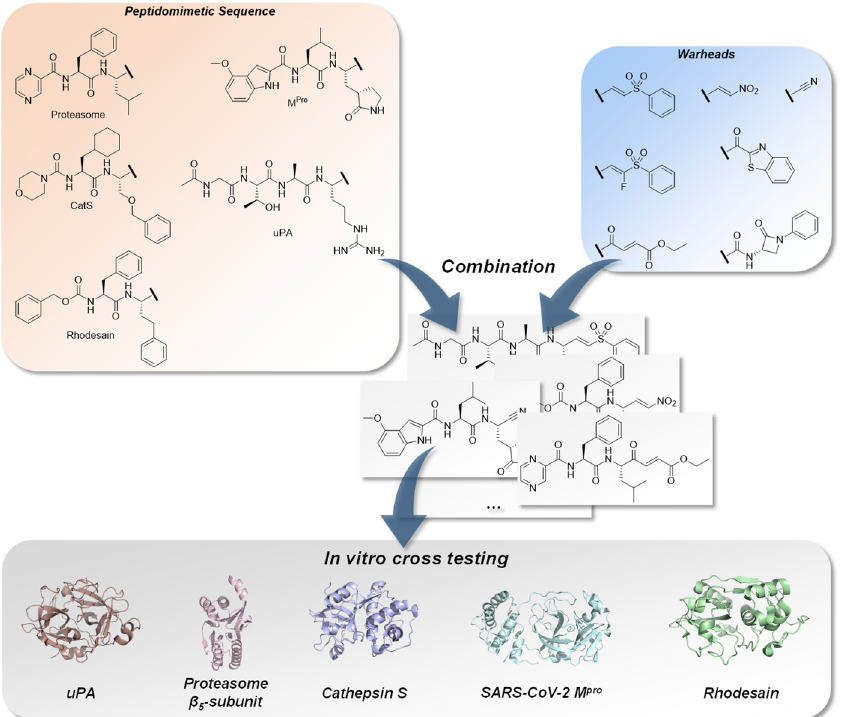
Figure 1. Combination of characteristic peptidomimetic inhibitor sequences for the targets: urokinase-type plasminogen activator (uPA), PDB-ID: 1W10 [41], proteasome ß 5-subunit, PDB-ID: 5LF3 [42], cathepsin S, PDB-ID: 1MS6 [43], SARS-CoV-2 main protease (M pro ), PDB-ID: 6XR3 [44] and rhodesain, PDB-ID: 2P7U [45], with selected warheads (vinyl sulfone, F-vinyl sulfone, nitroalkene, α -ketobenzothiazole, 4-oxoenoate, nitrile and β -lactam). The resulting compounds were tested on each target to determine affinity and selectivity.